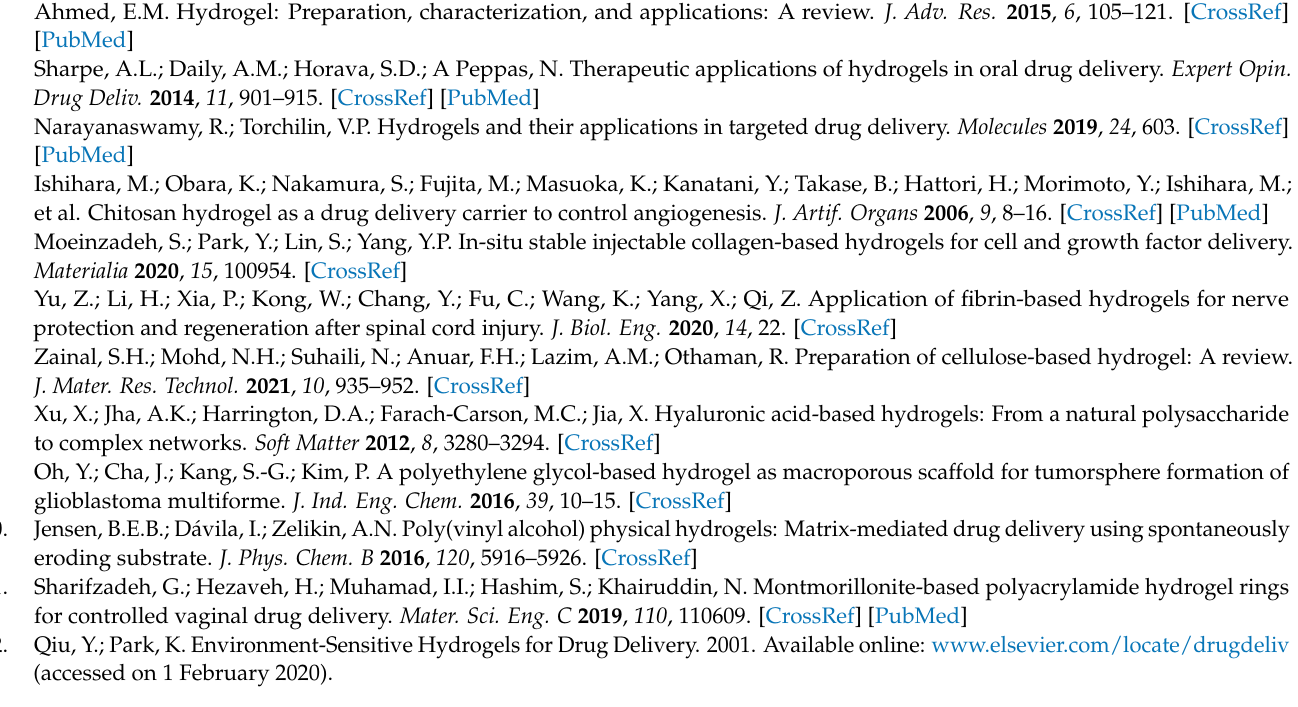
strain sweep for hydrogels with chitosan–BTC concentration 1–50 mM (supplementary material). Table S7. Frequency strain sweep for hydrogels with chitosan–BTC concentration 0.5–50 mM (supple- mentary material). Table S8. Frequency strain sweep for hydrogels with chitosan–BTC concentration 0.5–50 mM (supplementary